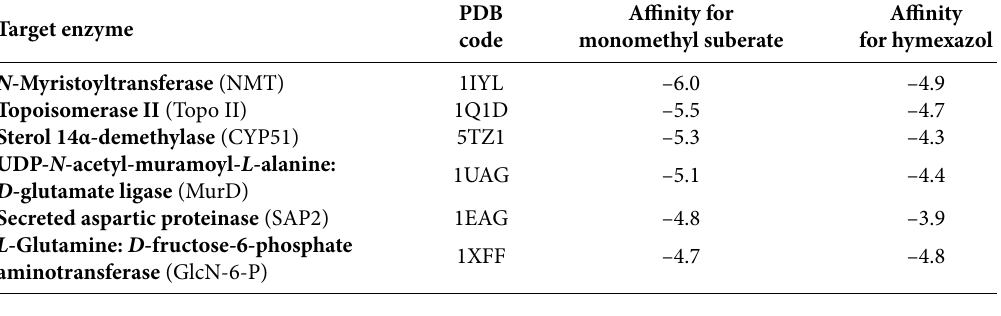
Table 2. Calculated affinities of monomethyl suberate and reference hymexazol to common antifungal enzymatic targets, Kcal/Mol